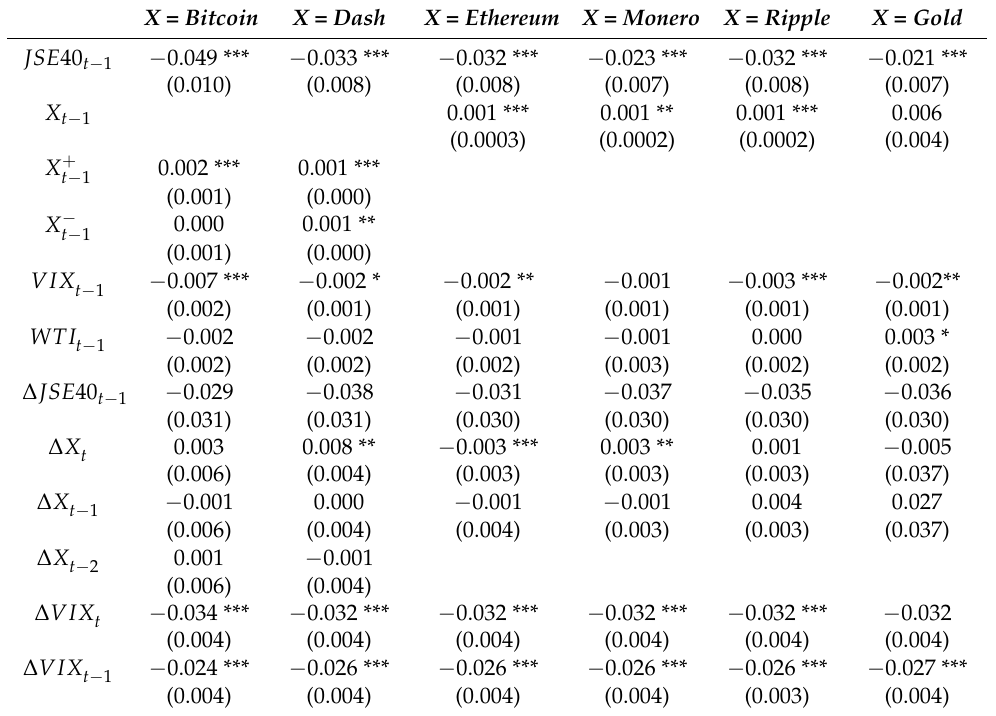
Table 7. Estimation results for JSE 40 before COVID-19.